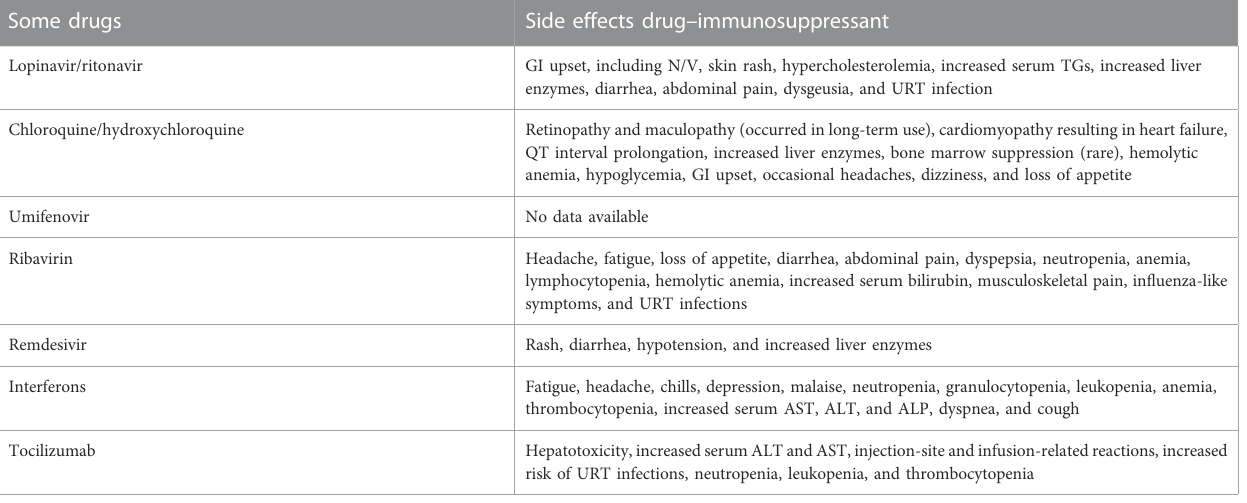
TABLE 2 Side effects drug – immunosuppressant in protocol COVID-19.